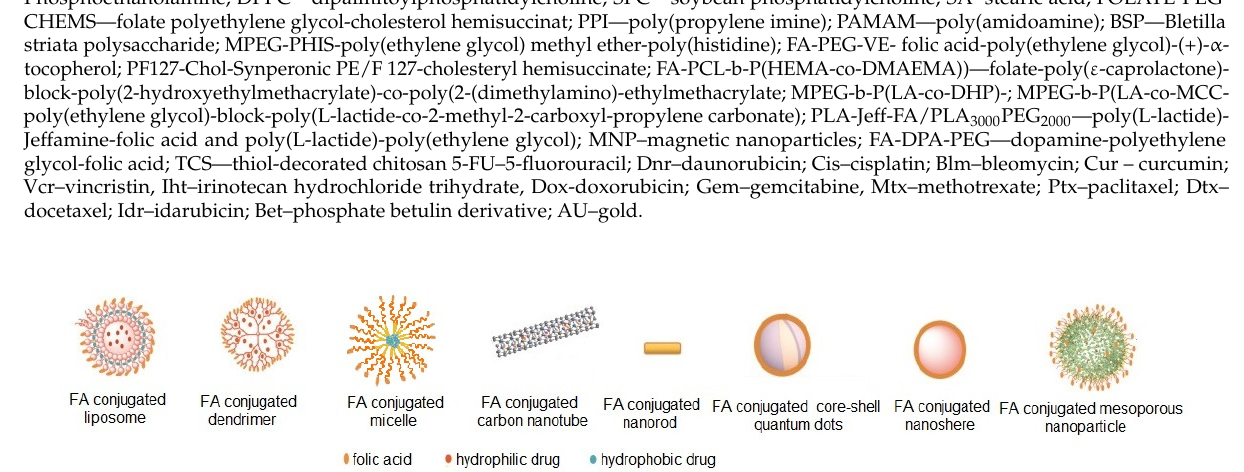
Figure 2. Scheme of different kinds of FA-targeted nanoparticles. After modification from (reproduced from Farran et al. [13]).